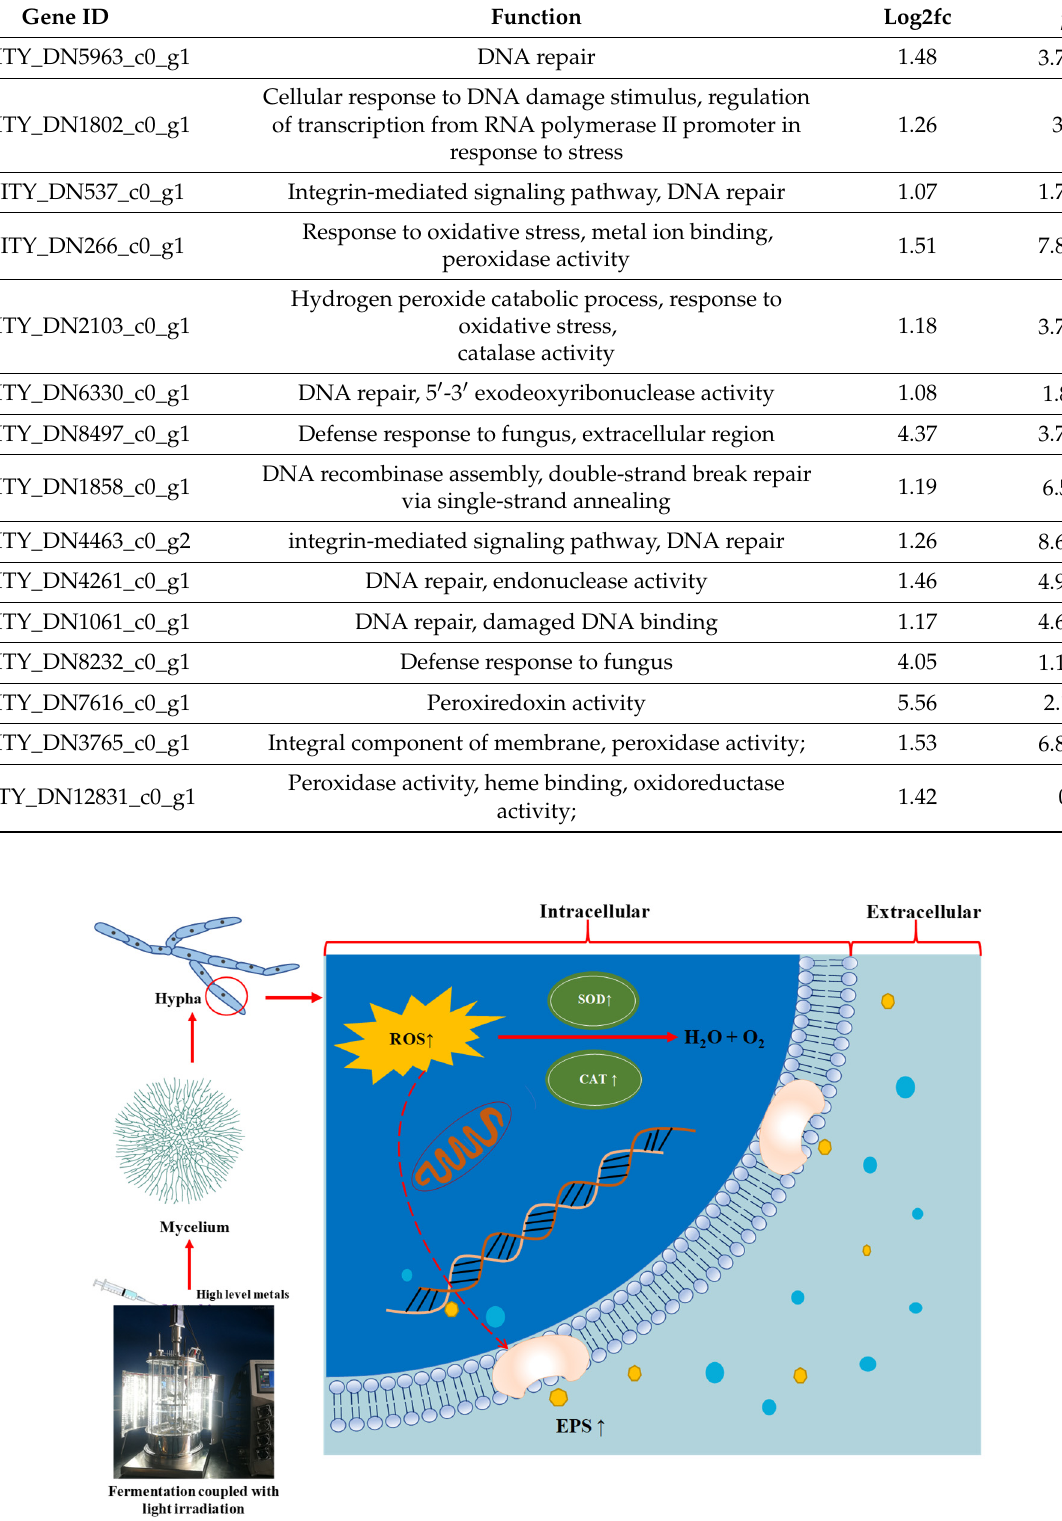
Table 2. Repression of up-regulated genes involved in oxidative stress.